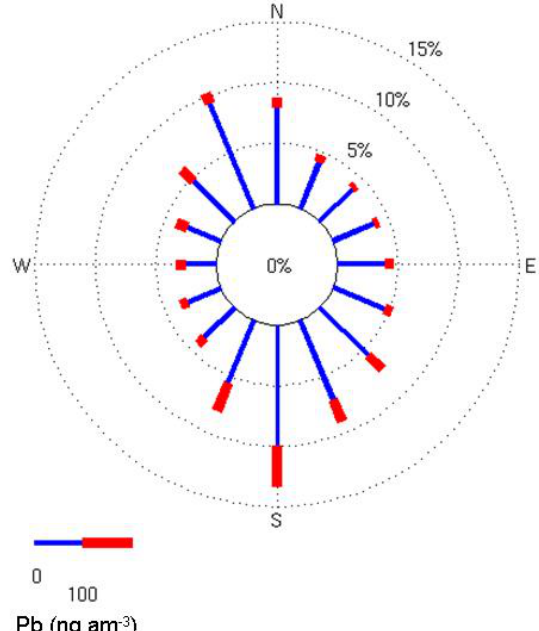
Fig. 14. Wind rose using Radar Wind Profiler (RWP) data up to 500m of the boundary layer. The length of the bars around the circle is proportional to the frequency of time that the wind blows from a particular direction. Shown in blue is the data for low Pb levels ( < 100ngam − 3 ) and in red, data for high Pb levels ( > 100ngam − 3